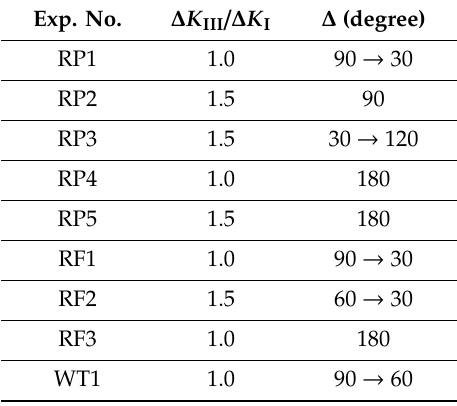
Table 3. Testing conditions for mixed mode I / III loading tests.